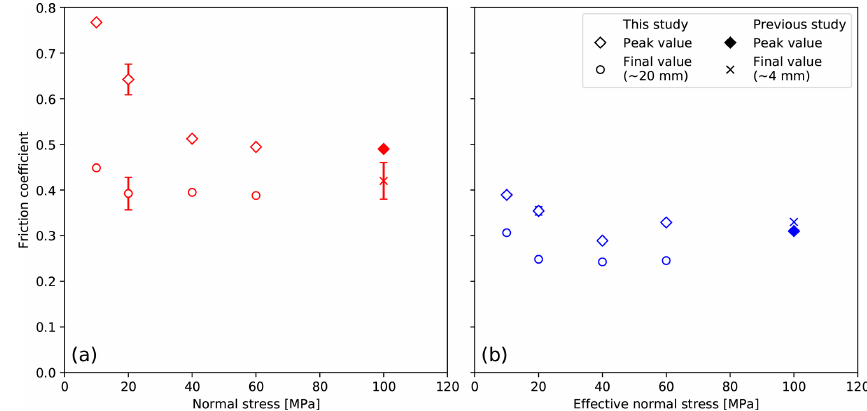
Figure 3. Relationship between normal stress and the peak or final friction coefficients for the dry (a) and wet (b) experiments. Data at a normal stress of 100MPa were obtained from previous experiments (Moore et al., 2001; Moore and Lockner, 2004, 2007; Morrow et al., 2000). The final friction coefficients do not show a clear trend with normal stress. For this study, the error bar represents the 1 σ SD among multiple data points. For 100MPa dry data, the final friction coefficient and the error bar denote the averaged value of stick-slip behavior and its amplitude, respectively. Note that the peak friction coefficient of wet brucite at an effective normal stress of 60MPa is high because of sudden stress drops in the initial stage of the shear displacement (Fig. S1). As these data may include some experimental artifacts, we do not use this peak value in this